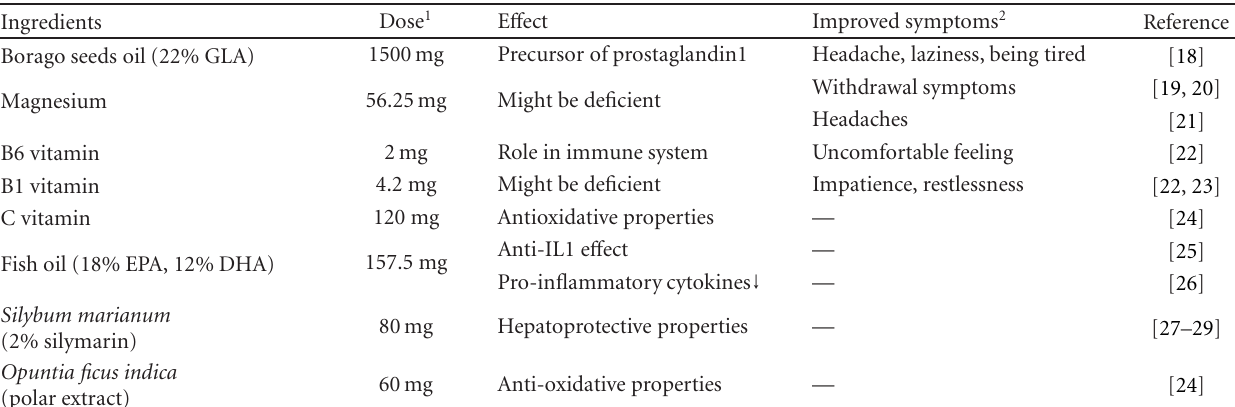
Table 1: Rationale for the ingredients included in After-E ff ect ©